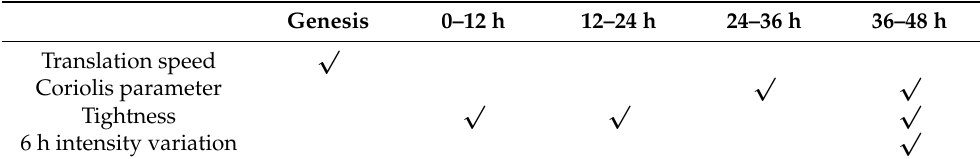
Table 6. Critical TC state features and their key intervals and quadrants.